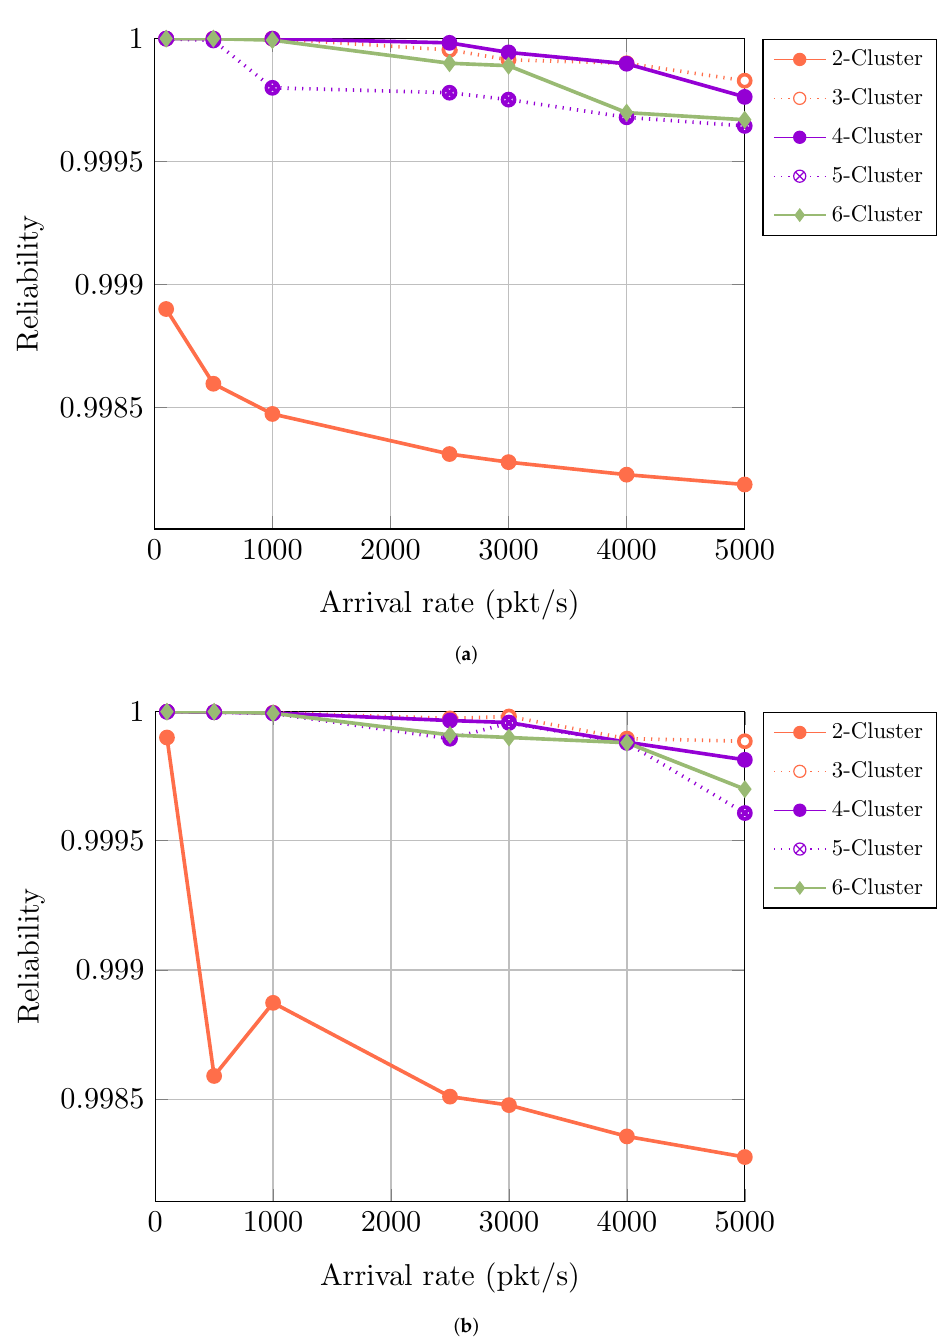
Figure 10. Determine reliability for different clusters using 7-packet duplication. ( a ) Mathematical, ( b )